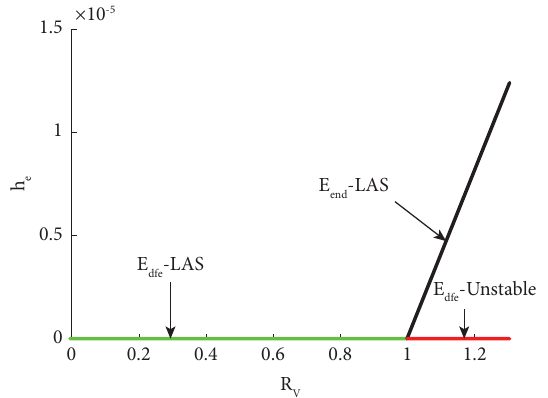
Figure 2: Transcritical bifurcation of model (2) when R